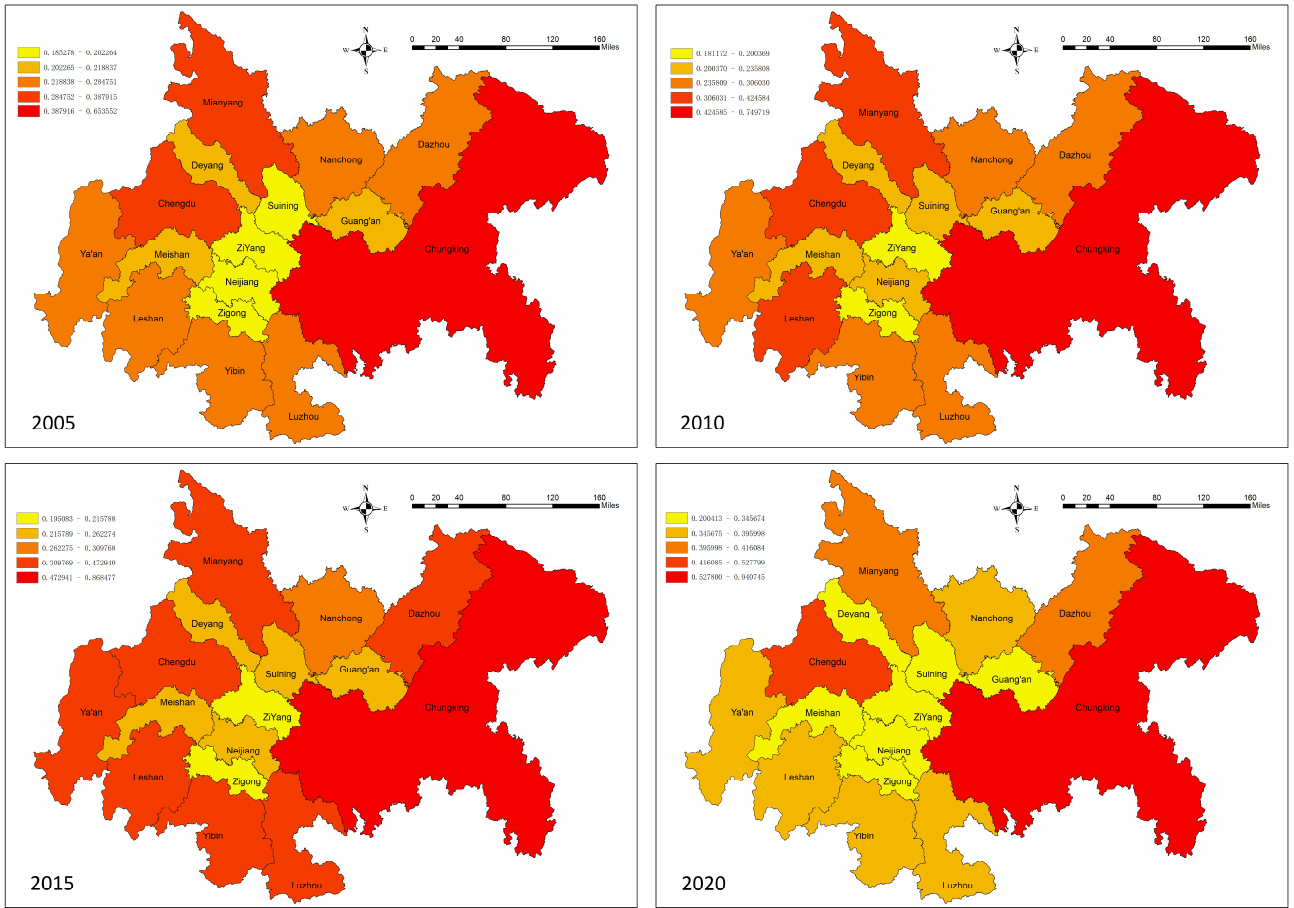
Figure 10. Spatial distribution of the level of coupling between economic–social development and ecosystem services in each city from 2005 to 2020.